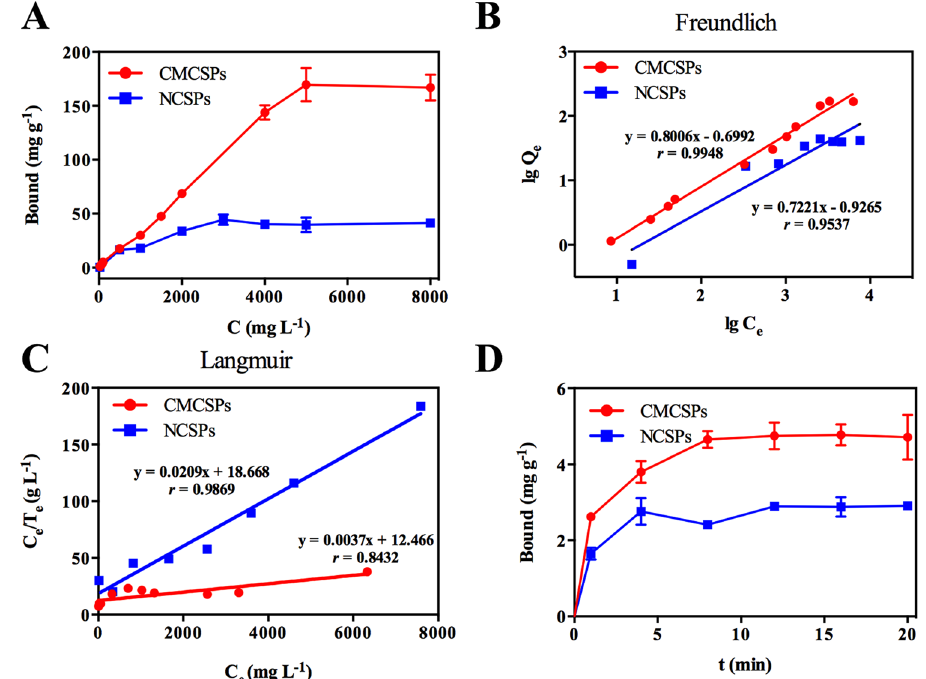
Figure 3. Binding properties and adsorption isotherm fitting of the FGFR4/CMCSPs and NCSPs. ( A ) Static adsorption isotherms; ( B and C ) adsorption isotherm fitting models; ( D ) kinetics adsorption.